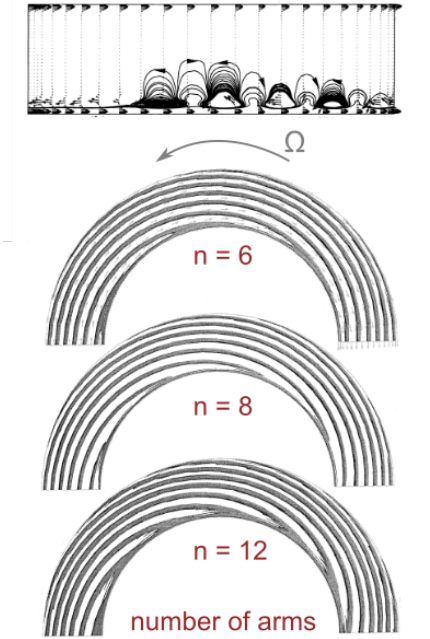
Figure 8. Axisymmetric and non-axisymmetric instability patterns [55], ( top ) and ( bottom